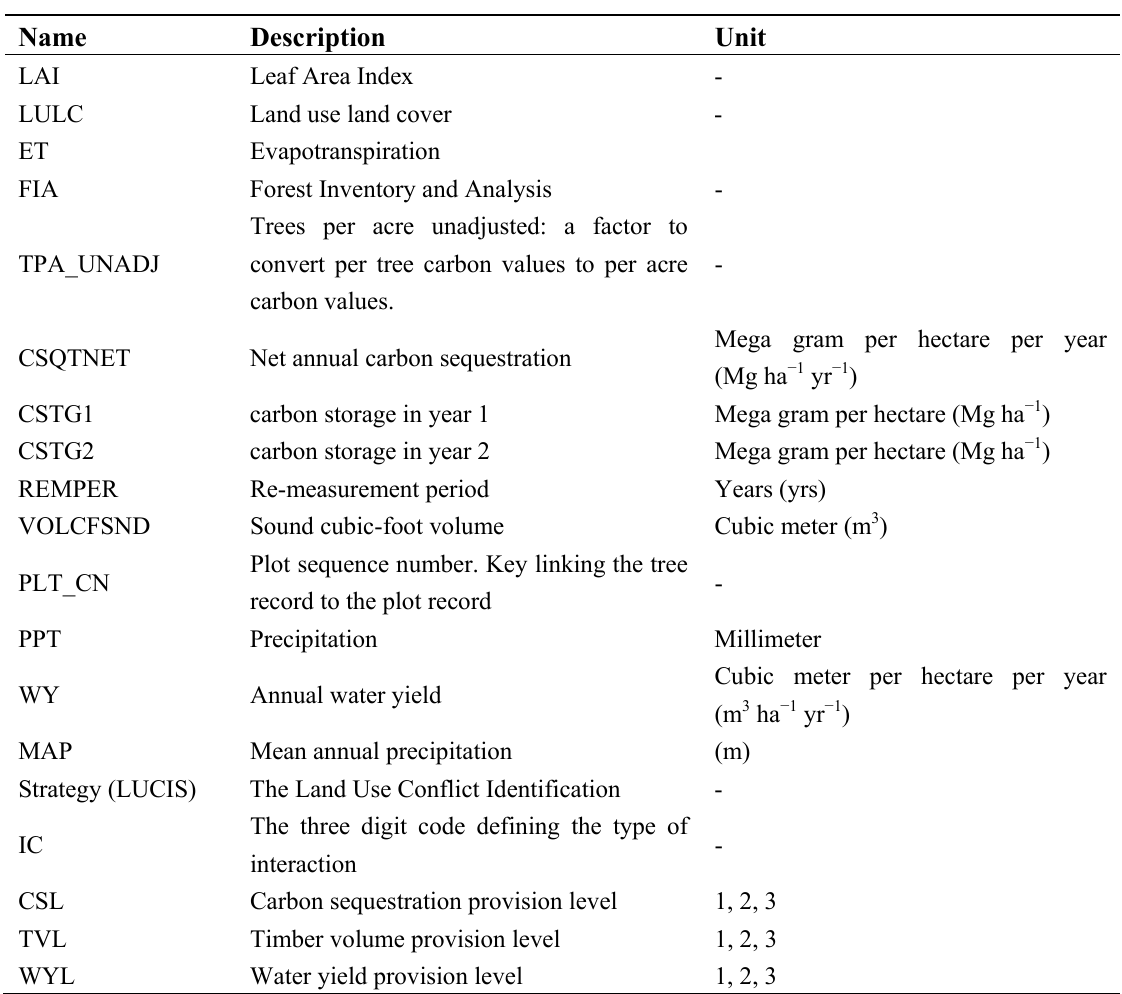
Table A1. Ecosystem Service Interaction and USDA Forest Service Forest Inventory and Analysis Acronyms and